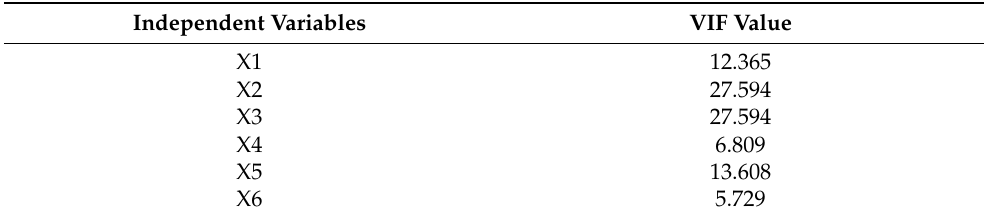
Table 15. Results of checking model 1 for multicollinearity.